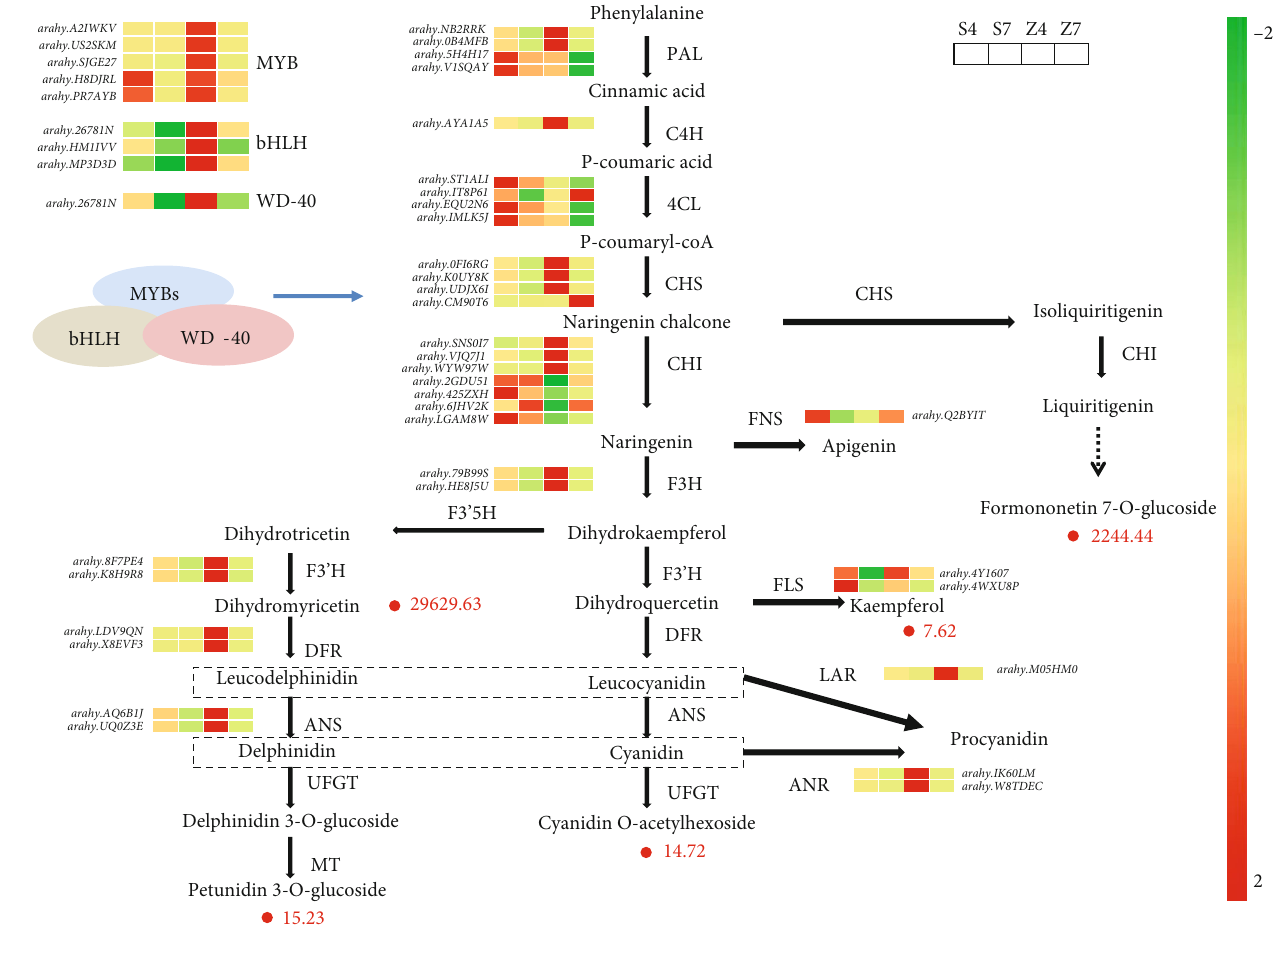
Figure 4: Transcript pro fi ling of genes in the fl avonoid and anthocyanin biosynthetic pathways in Shanghua15 and Zhonghua12 at R7 stages. Heat map represents changes in transcripts in fl avonoid and anthocyanin biosynthetic. Dots marked with red background represent increased abundances of metabolites. PAL: phenylalanine ammonia-lyase; C4H: cinnamic acid 4-hydroxylase; 4CL: 4-coumarate CoA ligase; CHS: chalcone synthase; CHI: chalcone isomerase; F3 ′ H: fl avanoid 3 ′ -hydroxylase; DFR: dihydro fl avonol 4-reductase; ANS: anthocyanidin synthase; FLS: fl avonol synthesis; FNS: fl avone synthase; LAR: leucocyanidin reductase; ANR: anthocyanin reductase; UFGT: